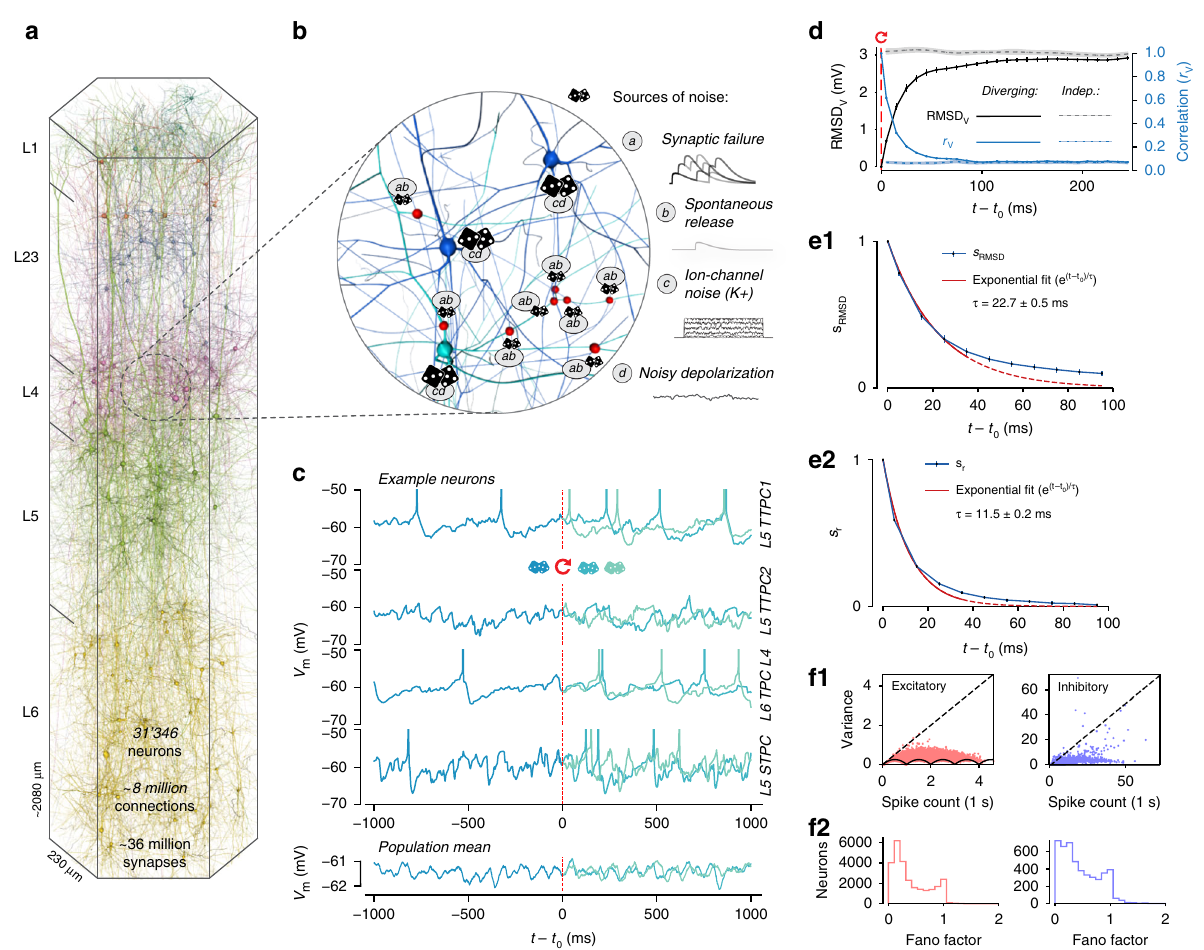
Fig. 1 Rapid divergence of spontaneous activity. a Morphologically detailed model of a neocortical microcircuit (NMC); depicted are 100 randomly selected neurons, out of 31,346 in total (~0.3%). Neurons are colored according to their layer. b Examples of simulated noise sources in the NMC-model: stochastic synaptic transmission, including ( a ) vesicle release failure and ( b ) spontaneous vesicle release ( “ miniature PSPs ” ) at all 36 million synapses; ( c ) probabilistic opening and closing of voltage-gated potassium channels in irregularly spiking inhibitory neurons (1137 out of 31,346 neurons); ( d ) a constant (cid:1) μ depolarizing current with a weak white noise component ( σ 2 ) injected into the somata of all neurons. c The membrane potential of four sample s s neurons (and population mean of all 31,346 neurons) during a network simulation of spontaneous activity. At t 0 , the state of the microcircuit is saved, and then resumed twice with identical initial conditions, but with different random seeds for all noise sources. d Root-mean square deviation (RMSD V ( t )) and correlation ( r V ( t )) of the somatic membrane potentials between pairs of resumed simulations diverging from identical initial conditions (mean of all neurons and 40 saved base states ± 95% con fi dence interval). The dashed lines depict the steady-state RMSD V and r V between independent simulations (i.e., resumed from different base states). e The similarity of the system ( s RMSD and s r ) de fi ned as the difference between the diverging and steady-state RMSD V and r V , normalized to lie between 1 (identical) and 0 (fully diverged) (mean ± 95% con fi dence interval). Exponential fi t of s RMSD and s r for t − t 0 < 40 ms (estimated time constant ± 68% con fi dence interval of fi t). f1 Mean spike count and variance of spike count of 40 independent trials of 1000 ms duration for all neurons in the microcircuit, plotted separately for excitatory neurons (red) and inhibitory neurons (blue). The dashed lines indicate the expected values for a Poisson process. Black lines indicate minimum variance due to the fact that the spike count has to be an integer. f2 Distribution of Fano factors (variance divided by mean spike count) corresponding to